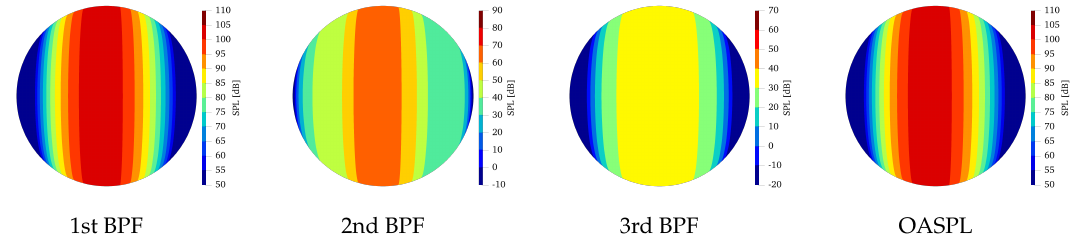
Figure 8. Sound directivity of isolated